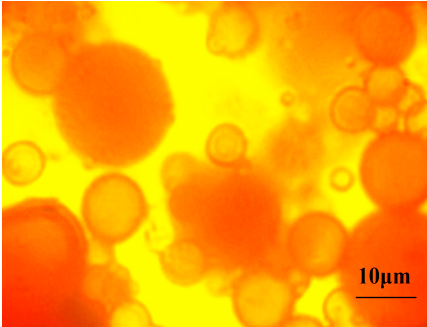
Figure 3. Fourier infrared spectra of matrix asphalt and new polymer modified asphalt.